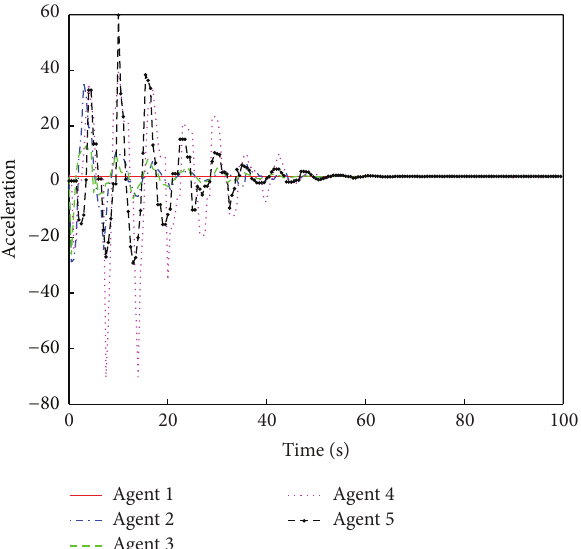
Figure 8: Consensus of acceleration for high-order